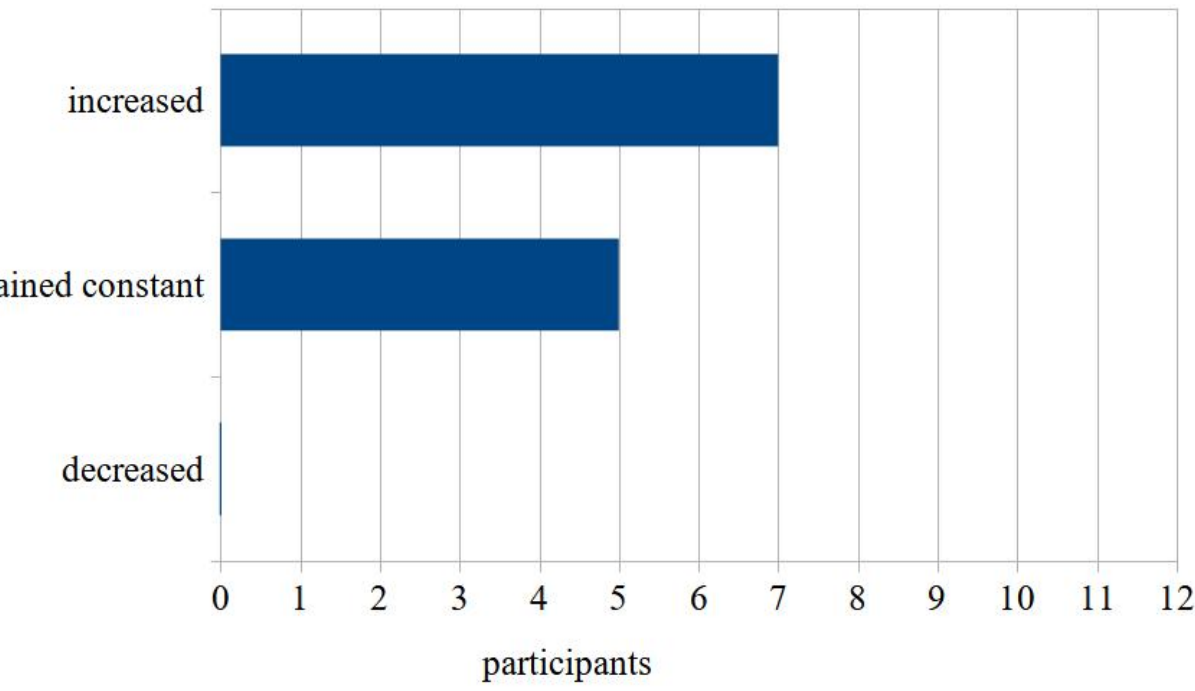
Figure 4. Evaluation of the statements within a single choice for the following statement: “My interest in family medicine is due to the patient interviews …” .